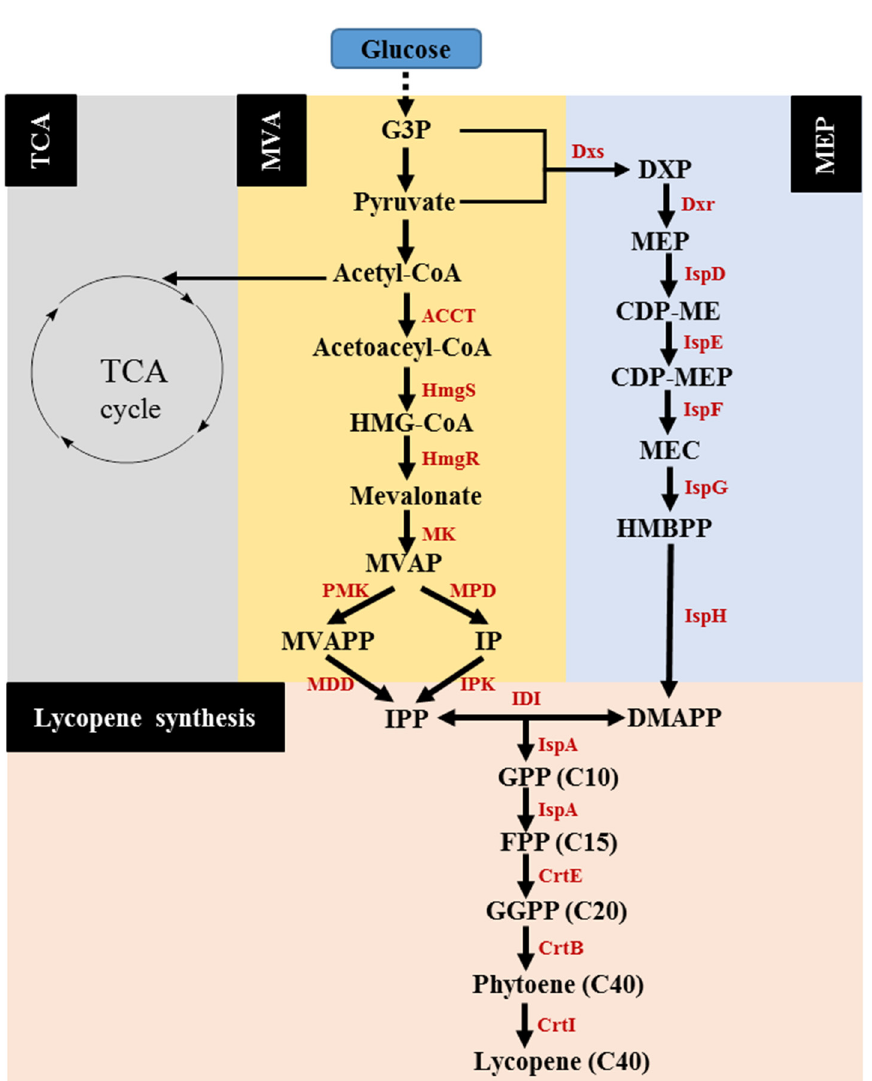
Figure 1. The metabolic pathways for lycopene production. G3P, glyceraldehyde 3-phosphate; DXP, 1-deoxy-d-xylulose-5-phosphate; MEP, methylerythritol phosphate; CDP-ME, 4-diphosphocytidyl-2 C -methyl-d-erythritol; CDP-MEP, 4-diphosphocytidyl-2 C -methyl-d-erythritol-2-phosphate; MEC, 2 C -methyl-d-erythritol-2,4-cyclo-diphosphate; HMBPP, 4-hydroxy-3-methyl-2-( E )-butenyl-4-diphosphate; HMG-CoA, 3-hydroxy-3-methylglutaryl-CoA; MVAP, mevalonate-5-phosphate; MVAPP, mevalonate-5-diphosphate; IP, isopentenyl phosphate; IPP, isopentenyl diphosphate; DMAPP, dimethylallyl diphosphate; GPP, geranyl diphosphate; FPP, farnesyl pyrophosphate; GGPP, geranylgeranyl diphosphate; DXS, DXP synthase; DXR, DXP reductoisomerase; IspD, CDP-ME cytidylyltransferase; IspE, CDP-ME kinase; IspF, MEC synthase; IspG, HMBPP synthase; IspH, HMBPP reductase; ACCT, acetoacetyl-CoA thiolase; HmgS, HMG-CoA synthase; HmgR, HMG-CoA reductase; MK, mevalonate kinase; PMK, MVAP kinase; MDD, MVAPP decarboxylase; MPD, MVAP decarboxylase; IPK, IP kinase; IDI, isopentenyldiphosphate isomerase; IspA, FPP synthase; CrtE, GGPP synthase; CrtB, phytoene synthase; CrtI, phytoene desaturase.